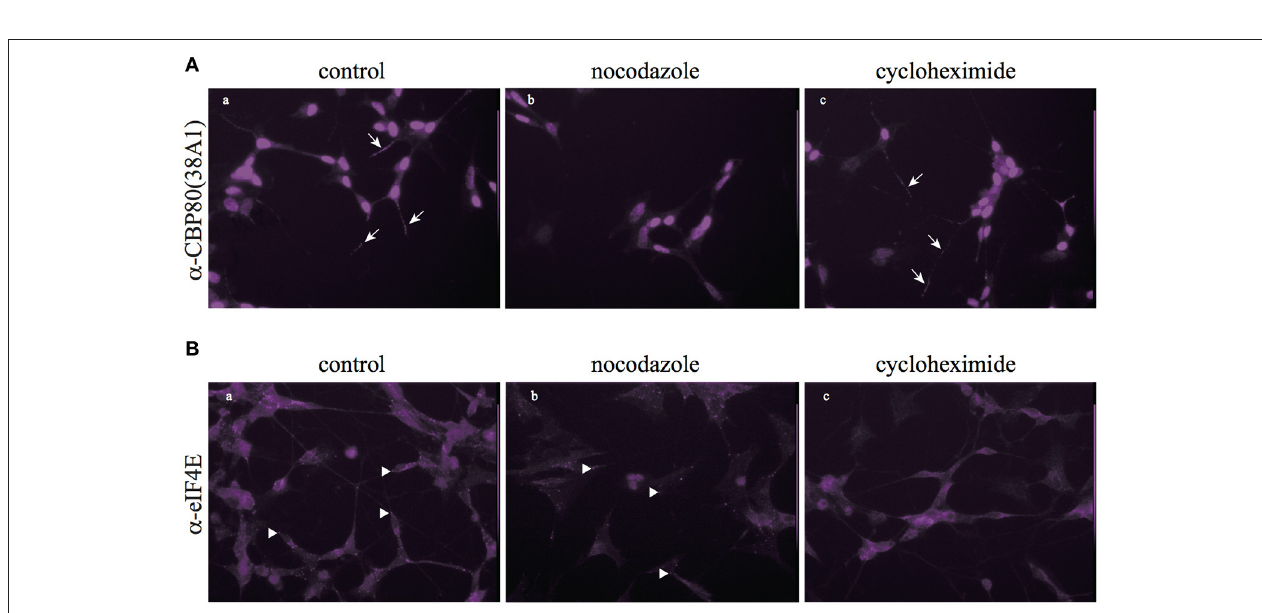
FIGURE 4 | Nocodazole and cycloheximide differentially regulate CBP80- and eIF4E-RNPs. (A) Microimages of CBP80-staining of SH-SY5Y cells treated with nocodazole or cycloheximide; arrows point to CBP80-positive puncta; (B) Microimages of eIF4E staining of SH-SY5Y cells eIF4E treated with nocodazole or cycloheximide; arrowhead point to eIF4E-positive